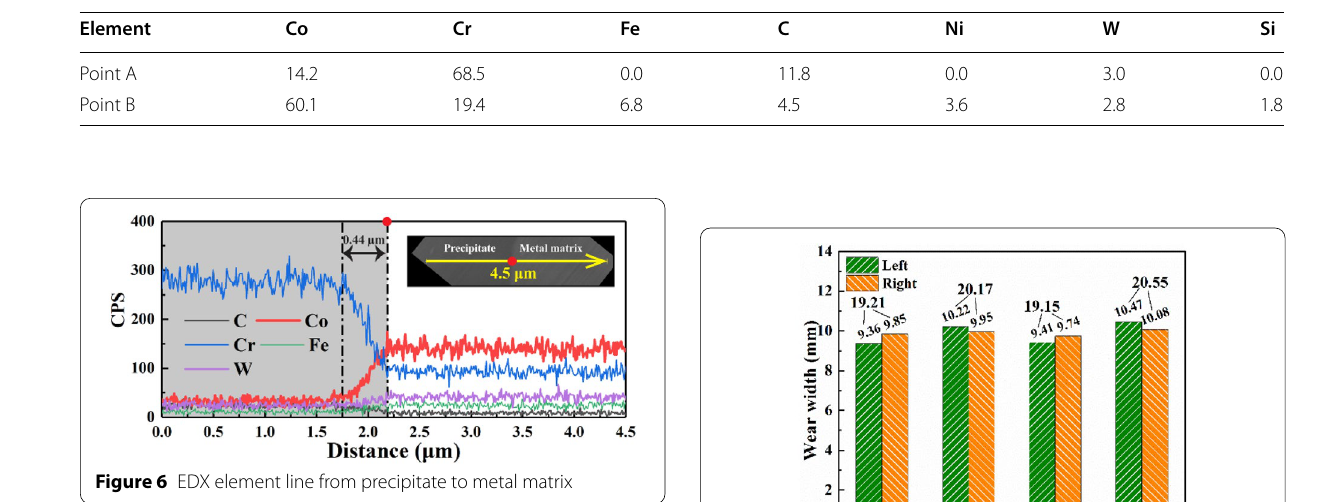
Table 1 Chemical composition of precipitate and metal matrix (mass fraction, %)